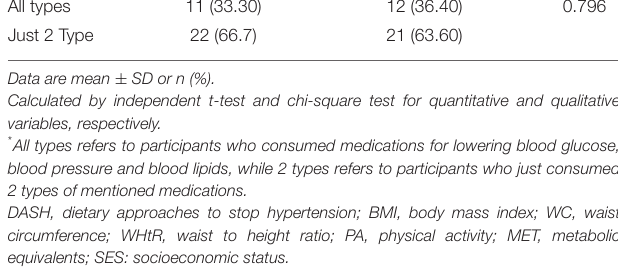
Table 4 indicates the anthropometric indices and biochemical tests at baseline and after 12 weeks of intervention in postmenopausal diabetic patients. Baseline values for weight (the